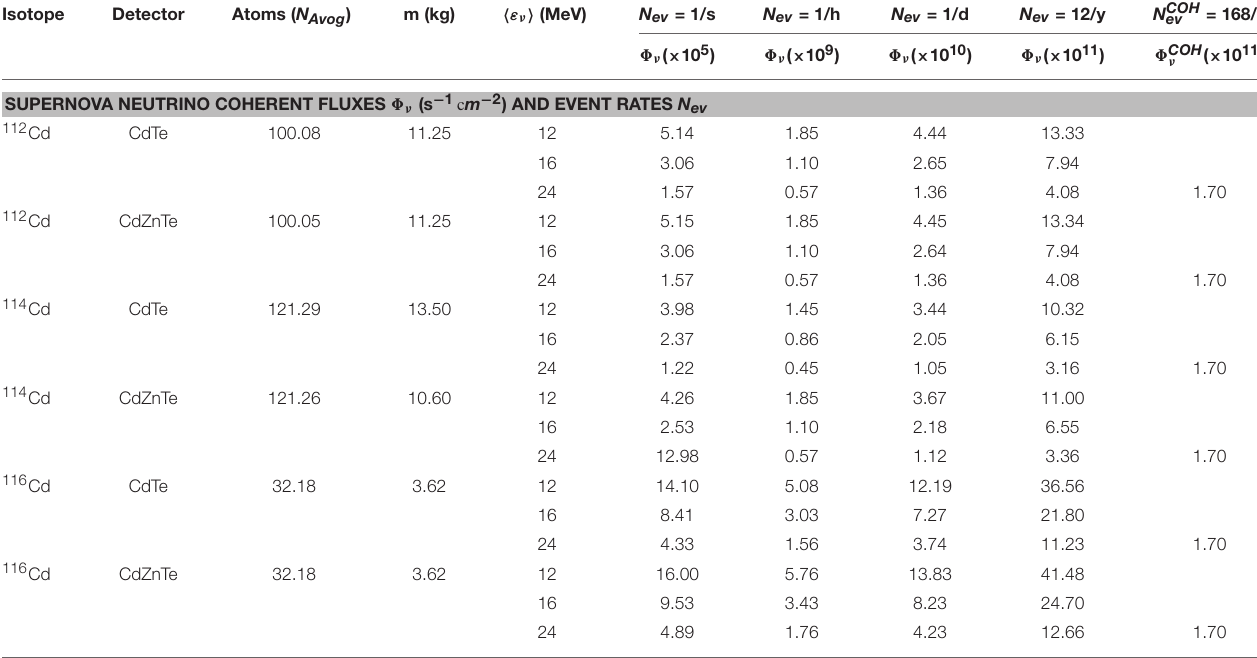
TABLE 5 | Neutrino fluxes 8 ν ( ε ν ) and corresponding event rates N ev estimated to be recorded on 112,114,116 Cd isotopes of two detector materials (CdTe and CdZnTe) of the COBRA experiment [3, 4, 26]. Isotope